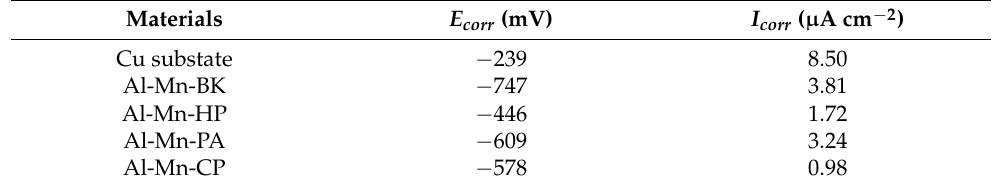
Figure 10. Potentiodynamic polarization curves of the Cu substrate, Al-Mn-BK, Al-Mn-HP, Al-Mn-PA, and Al-Mn-CP coatings in a 3.5 wt % NaCl solution at a scan rate of 1 mV s − 1 . Table 2. Corrosion parameters received from the polarization curves in Figure 10.